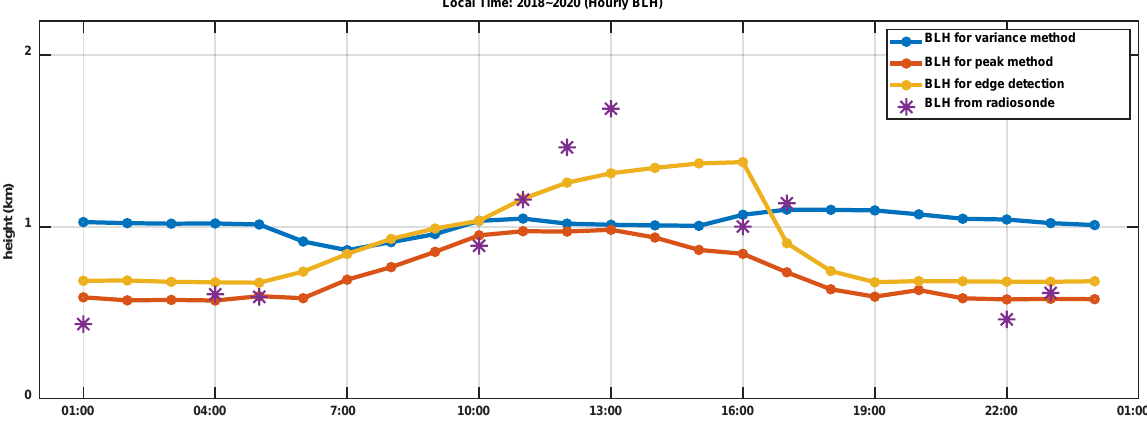
Figure 7. Hourly BLHs retrieved using the variance, peak, and ED methods. The hourly BLHs retrieved using the variance method were higher and lower than those obtained by RS measurements at nighttime (from 00:00 to 06:00 and from 18:00 to 24:00). BLHs obtained using the variance method were higher than RS measurements at 12:00. The BLHs remained stable from 07:00 to 14:00 and increased from 14:00 to 17:00. The BLHs obtained using the peak method slowly increased from 06:00 to 12:00 and decreased from 12:00 to 18:00. The BLHs retrieved using ED increased from 06:00 to 16:00,